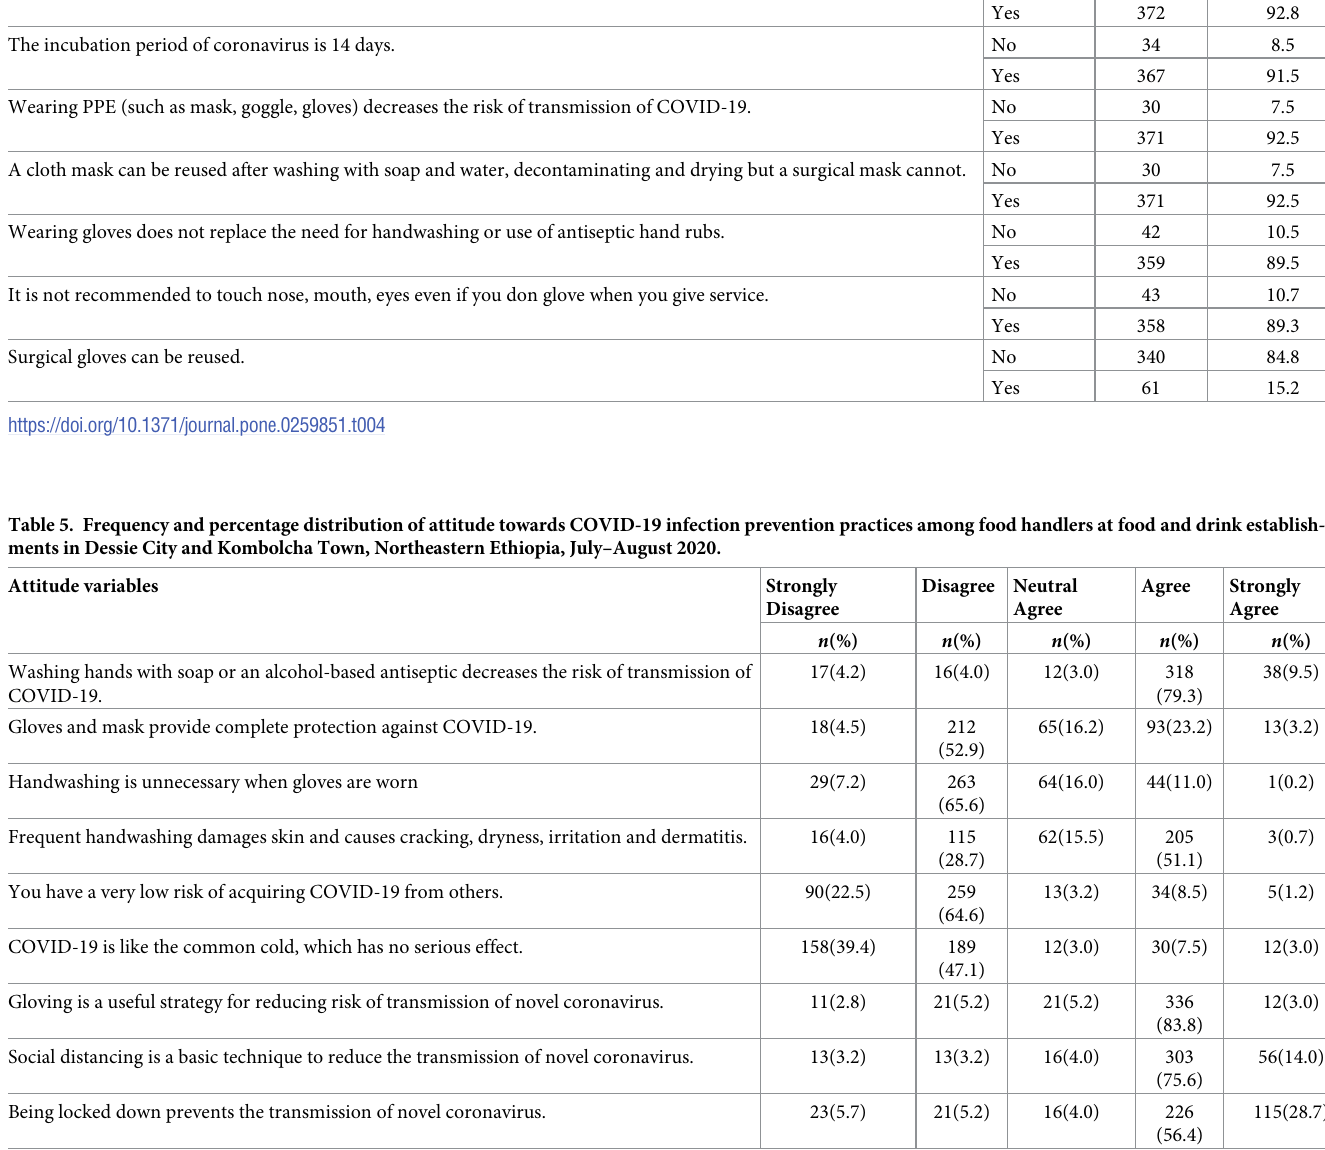
Table 4. Frequency and percentage distribution of knowledge about COVID-19 infection prevention practices among food handlers at food and drink establish- ments in Dessie City and Kombolcha Town, Northeastern Ethiopia, July–August 2020. Variables Responses Frequency Percentage (%)